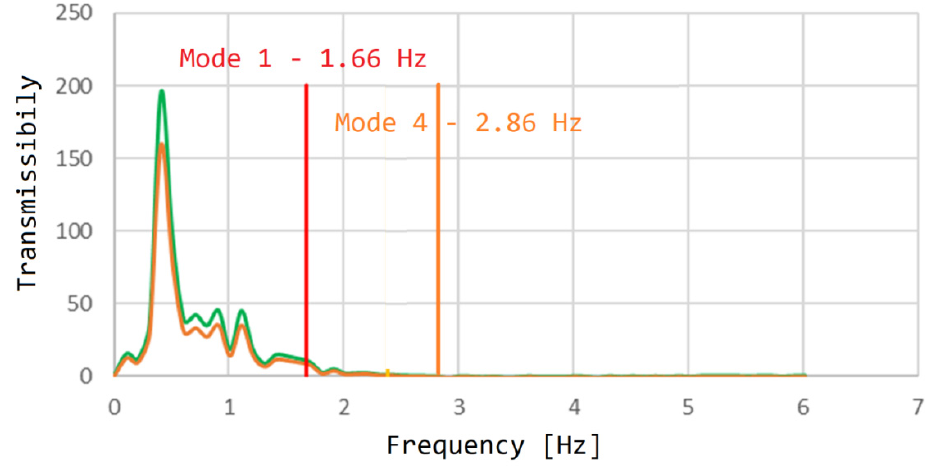
Figure 17. The response of the platform subjected to excitations in the direction of OX.